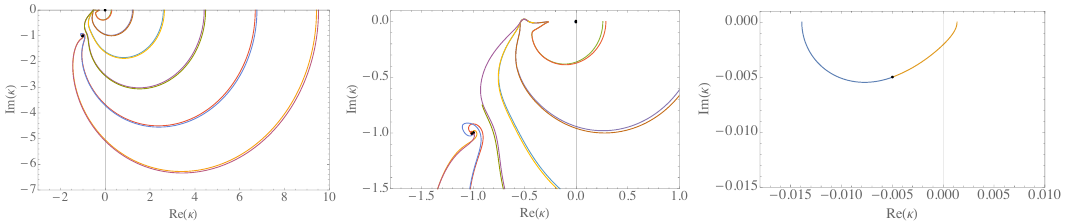
Figure 14 . The trajectory of a host of saddles as t increases from 0 to shown at various levels of magni(cid:12)cation. Black dots indicate the asymptotic positions of decaying saddles, however most saddles are seen to be oscillating saddles in these plots. Parameters are (cid:11) L = 0 : 99 ; (cid:11) H = i; (cid:11) I = 0 : 97 ;